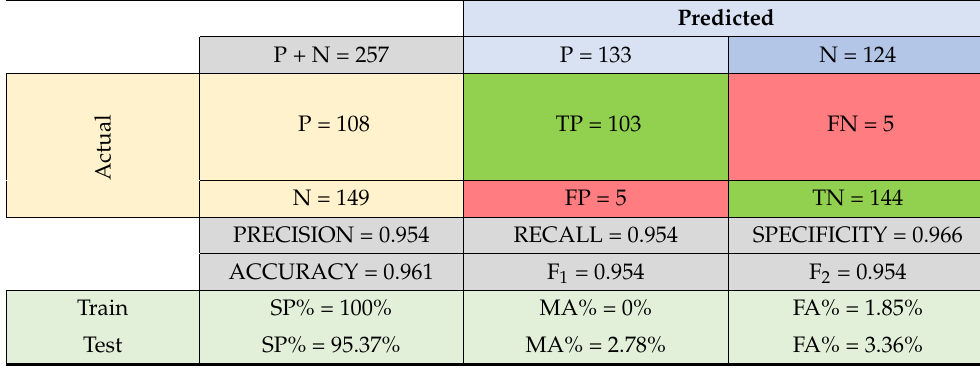
Figure 3. JET-disrupted discharge #94218: ( a ) Time evolution of the seven plasma dimensionless parameters: temperature (𝑇𝑒 (cid:3043)(cid:3033) ) , plasma density (𝑛𝑒 (cid:3043)(cid:3033) ) , and radiated power ( 𝑅𝑎𝑑 (cid:3043)(cid:3033)(cid:2879)(cid:3004)(cid:3023)(cid:3002) ) , and ( 𝑅𝑎𝑑 (cid:3043)(cid:3033)(cid:2879)(cid:3025)(cid:3005)(cid:3010)(cid:3023) ) peaking factors, internal inductance 𝑙 (cid:3036) , radiated fraction of the total input power (𝑃 (cid:3033)(cid:3045)(cid:3028)(cid:3030) ) , normalized locked mode amplitude (𝐿𝑀 (cid:3041)(cid:3042)(cid:3045)(cid:3040) ) signal; ( b ) disruptive likelihood of the dis- rupted discharge #94218 supplied by MLP-NN. The dashed black line identifies the alarm time. Table 4. Confusion matrix and performance indices of the MLP-NN prediction model evaluated on the test